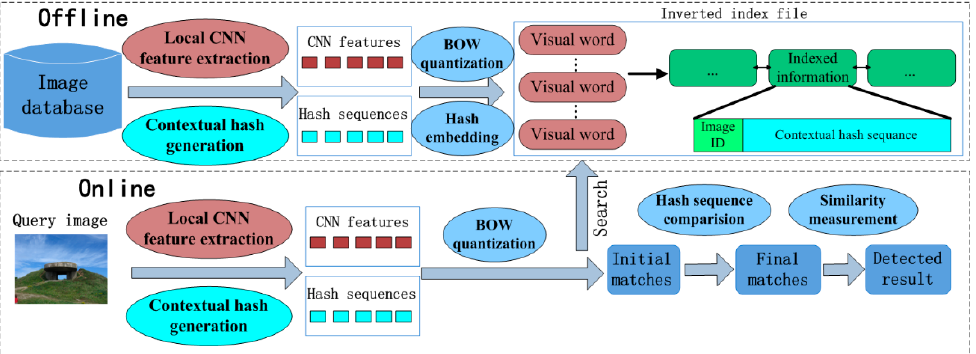
Figure 2. The framework of the proposed copy detection method.